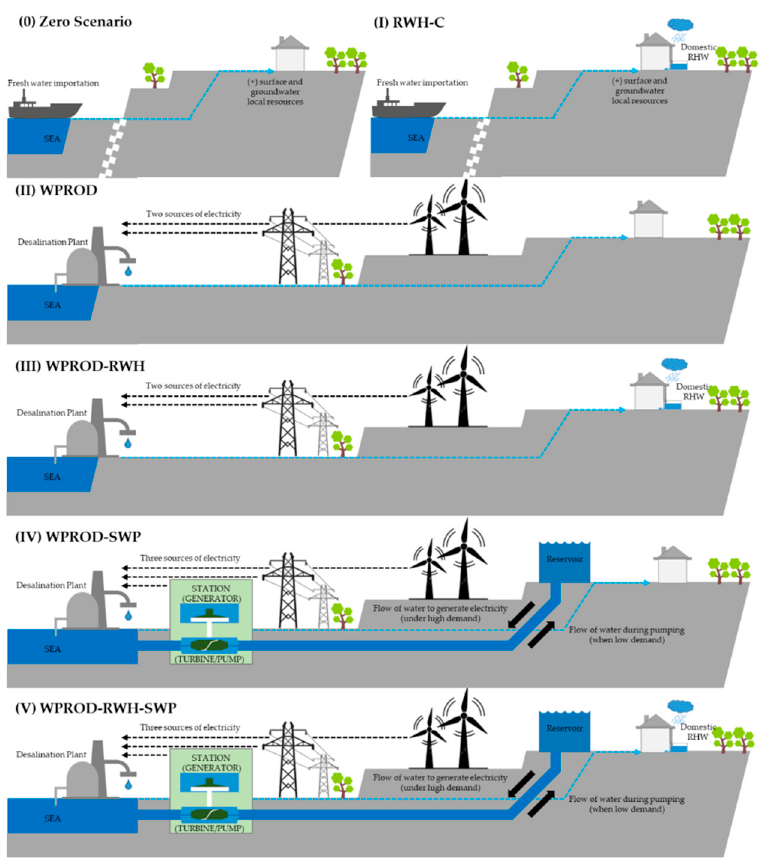
Figure 2. Schematic representation of water resources management scenarios.